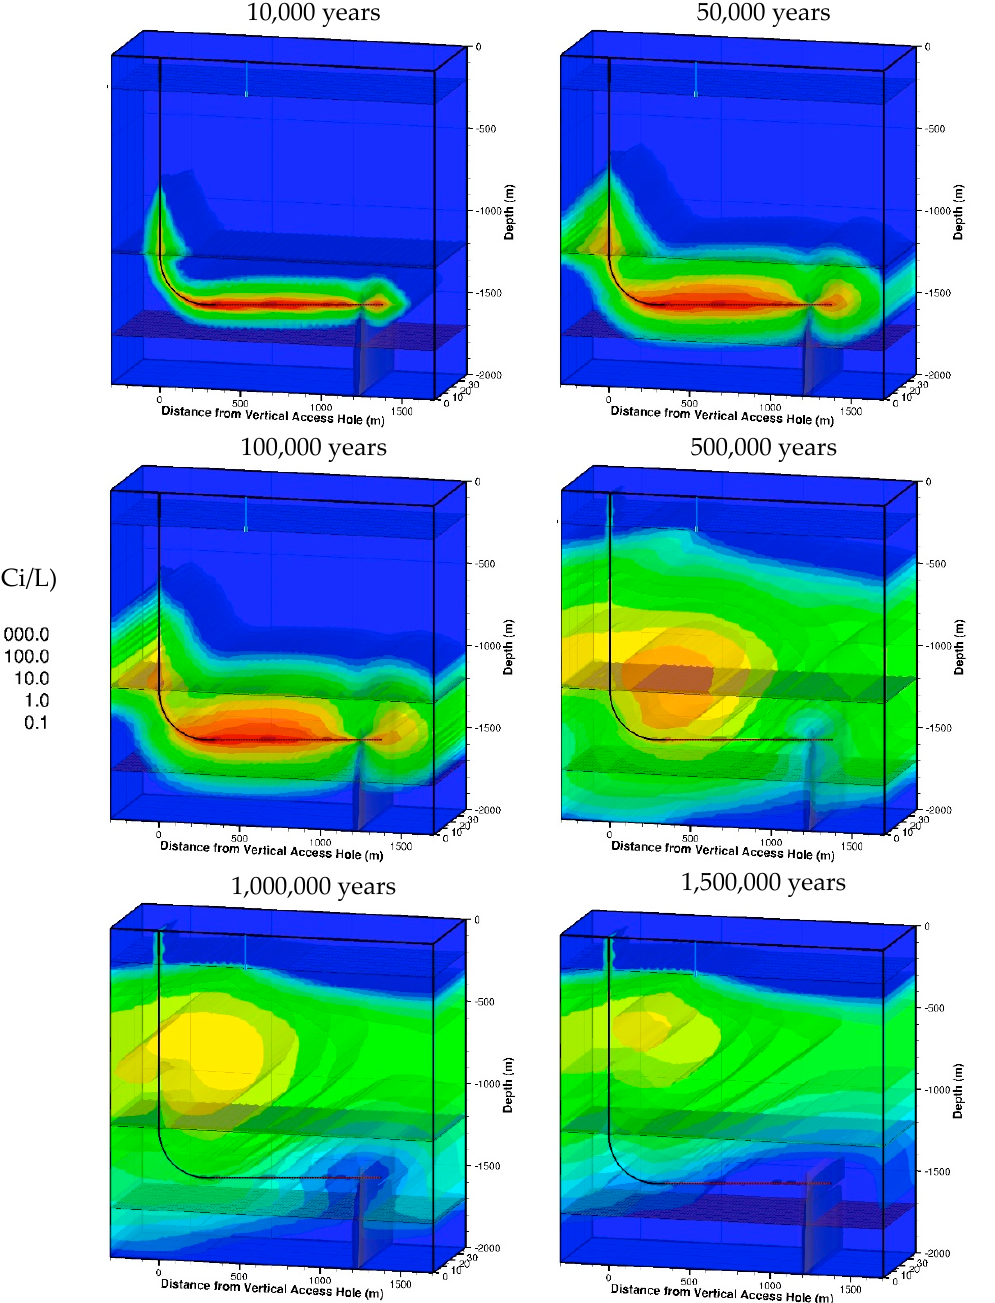
Figure 10. Distribution of 129 I activity at different times for one ‐ fault scenario with poorly ‐ sealing backfill.